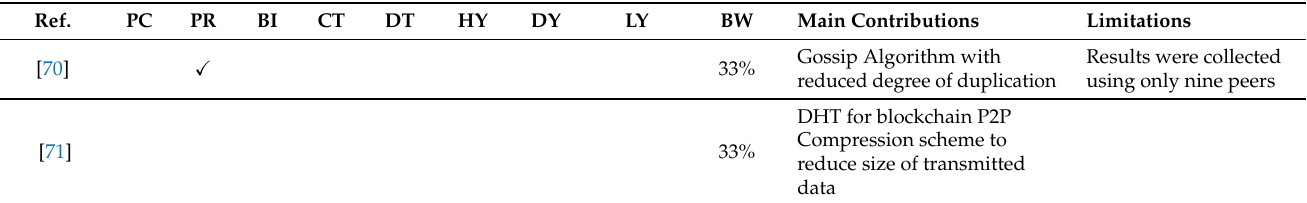
Table 6. Comparison of Network Layer Techniques. PC = Public, PR = Private, BI = Blockchain- IoT, CT = Centralized Topology, DT = Distributed Topology, HY = Semi-Distributed Topology, DY = Dynamic Topology, LY = Latency, BW = Bandwidth, Bandwidth = Reduction in TotalNnetwork Bandwidth due to Minimization of Duplicates or Reducing Overhead Associated with Distributed P2P Topology